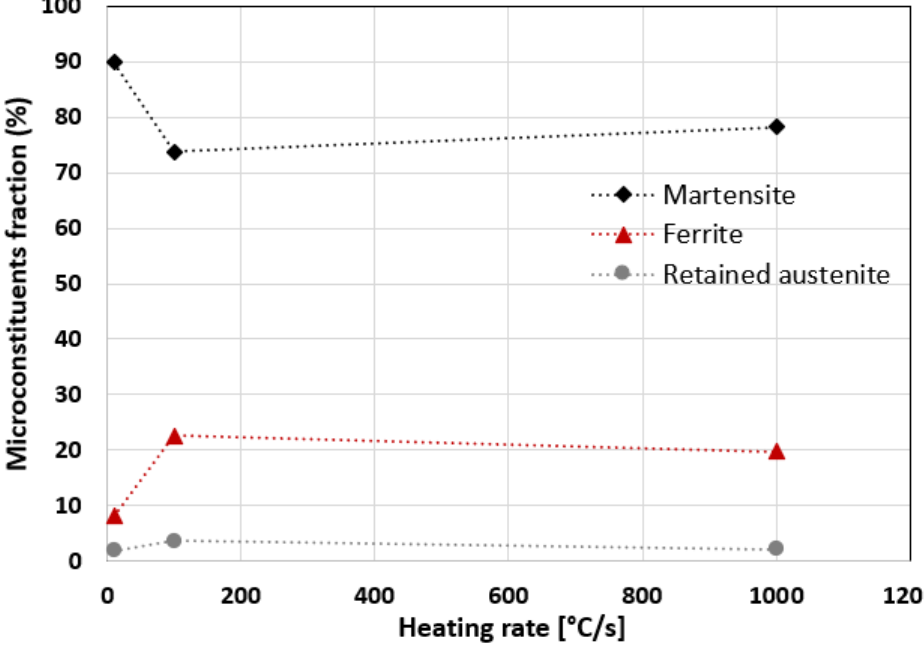
Figure 15. Microstructural evolution at different HRs for peak temperature at Ac3: 950 °C (data from [57]; steel chemical composition: 0.2% C).